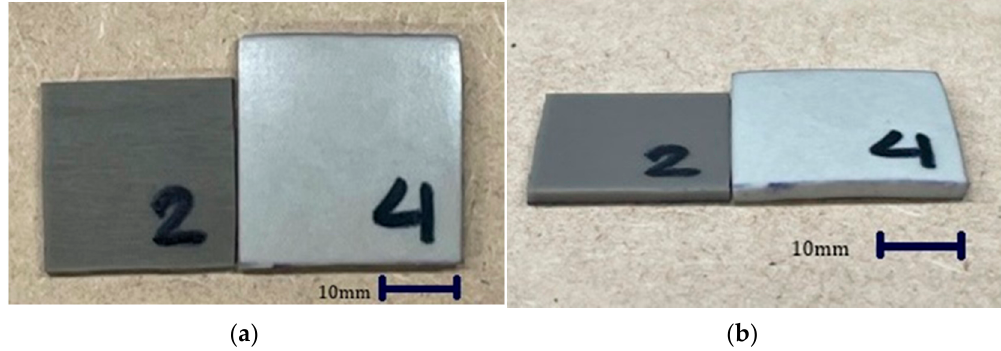
Figure 6. Changes in the volume and color of the specimens: ( a ) Top view ( b ) Side view. The volume of the specimen increased by 102.97% and the color changed from dark to light gray; however, the specimen that had a higher foaming ratio turned brighter. Shore A hardness was measured using a digital hardness tester (HANDO-Midyo, Korea, Shore A hardness tester, Model No. HD-KR10A). The hardness of the non-foamed ceramic urethane was 70, and that of the microcellular foamed ceramic urethane was 56 (Figure 7), that is, the hardness decreased by approximately 24.5% [18].